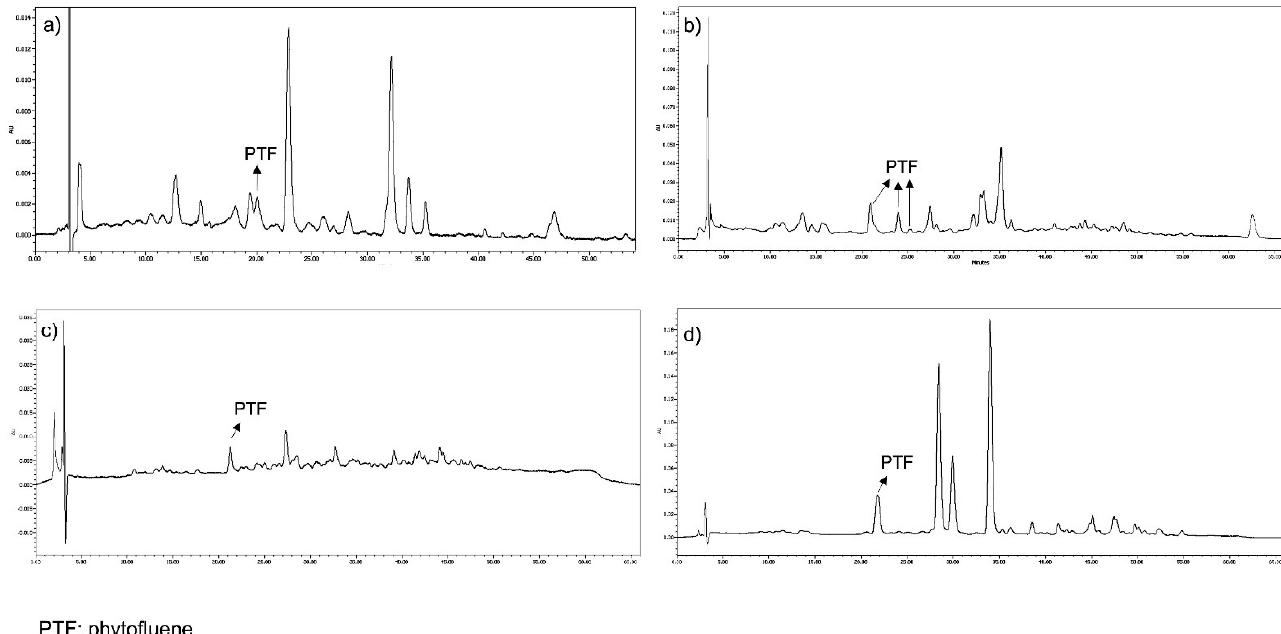
Figure 2. Chromatograms at 285 nm of a sample of serum ( a ), faeces ( b ), orange ( c ) and pumpkin ( d ).